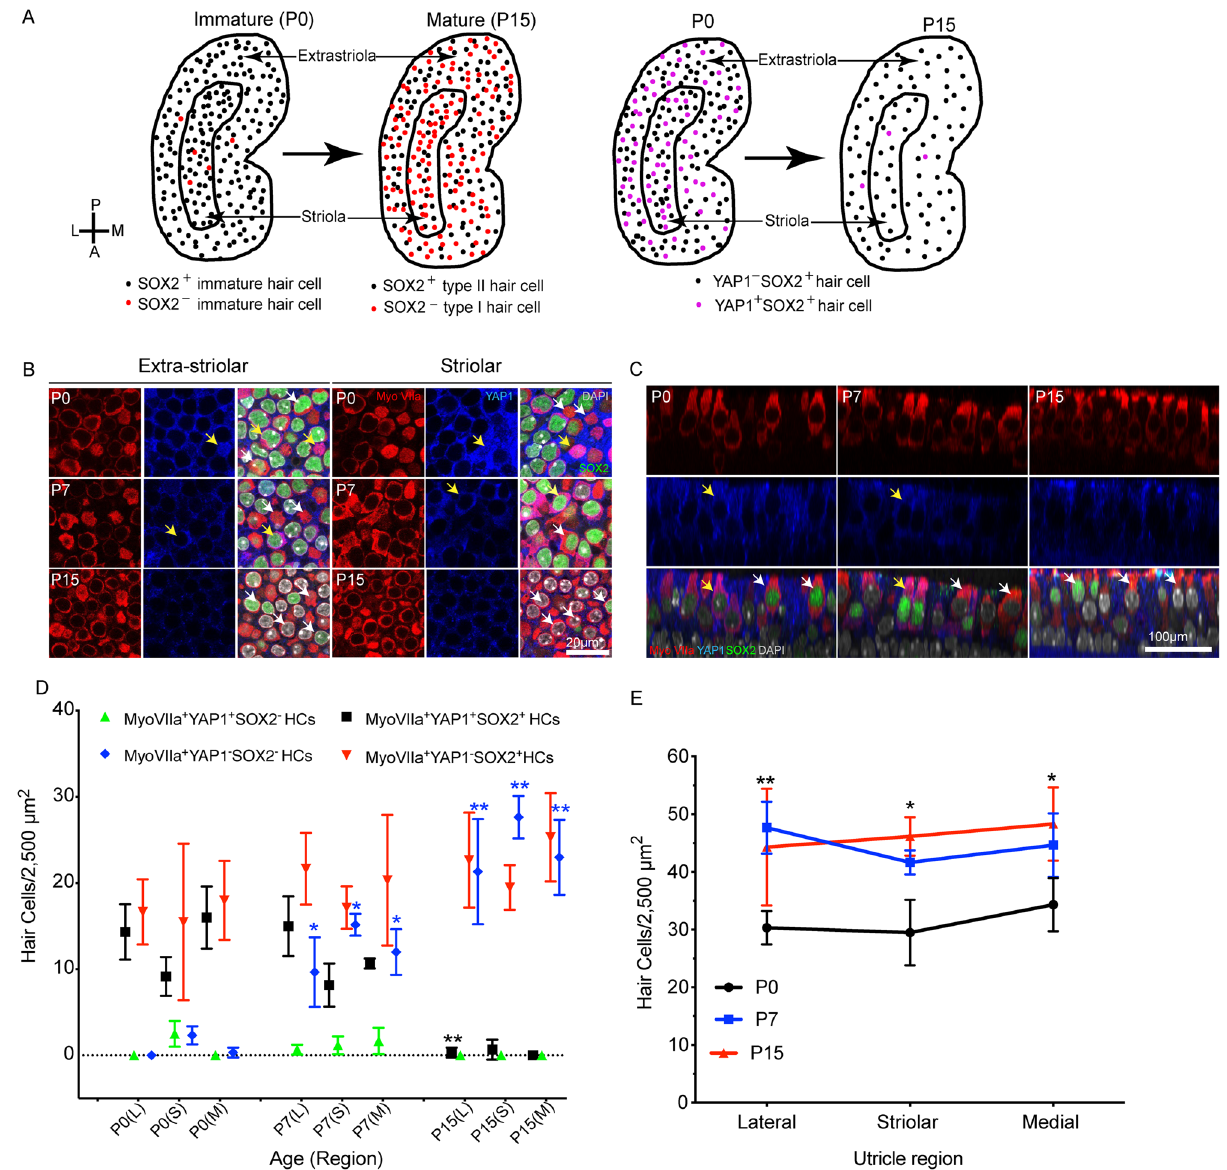
Figure 1. YAP1 expression profile in the developing mouse utricle. Mouse utricles were collected at postnatal days 0 (P0), P7 and P15. Immunostaining was performed using antibodies against Myosin VIIa (hair cell marker, red), SOX2 (green), and YAP1 (blue). All cell nuclei were labeled with DAPI (grey). One or two images were taken from lateral (L) and medial (M) extrastriolar regions and from the striolar (S) region of each utricle. ( A ) Schematic representation of molecular and cellular changes in hair cells during utricular development. ( B ) YAP1-positive hair cells (magenta) were observed at P0 and P7, but were very rare at P15. Yellow arrows indicate MyoVlla + YAP1 + hair cells (magenta) and white arrows indicate MyoVlla + YAP1 - hair cells (red). Representative images were taken from XY planes of Z-stack images. ( C ) Representative orthogonal images showing YZ planes of P0, P7 and P15 mouse utricles. Yellow arrows indicate MyoVlla + YAP1 + SOX2 + /- hair cells (magenta) and white arrows indicate MyoVlla + YAP1 - SOX2 +/- hair cells (red). ( D , E ) Quantitative data on utricle hair cell density, YAP1 and SOX2 expression during postnatal development. All data were obtained from 50 X 50 µm regions within the lateral extrastriolar, striolar and medial extrastriolar regions of each utricle. ( C ) During postnatal development, we observed significant increases in MyoVlla + YAP1 - SOX2 - hair cells (blue) (p < 0.0001) and decreases in MyoVlla + YAP1 + SOX2 + hair cells (black) (L p = 0.0013) relative to P0. MyoVlla + YAP1 - SOX2 + hair cells (red) and MyoVlla + YAP1 + SOX2 - hair cells (green) did not change (relative to P0). ( D ) Increases in hair cell density were observed throughout the utricle at P15, relative to P0. Data expressed as mean ± SD. Statistical test was two-way ANOVA followed by Tukey’s post hoc test (*p indicate significance relative to P0 and **p indicate significance relative P0 as well as P7, p value < 0.05). N = 3–6